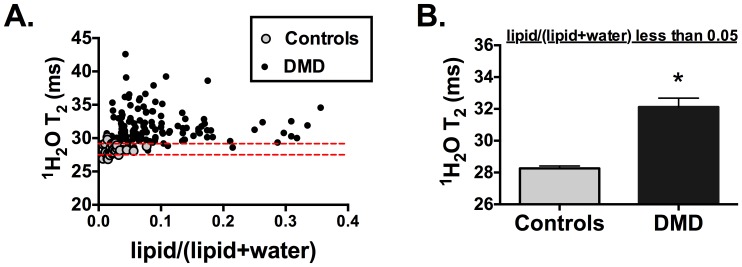
Scatterplot displaying the relationship between 1H2O T2 and lipid/(lipid+water) in the soleus of controls and boys with DMD.Red dotted lines denote 95% confidence interval of MRS 1H2O T2 in controls (A). In those with low lipid/(lipid+water) levels (i.e., less than 5%), the 1H2O T2 was longer in DMD (n = 34) than controls (n = 29) (B). * denotes significantly different (<0.05) than controls. Bars represent mean (SEM).